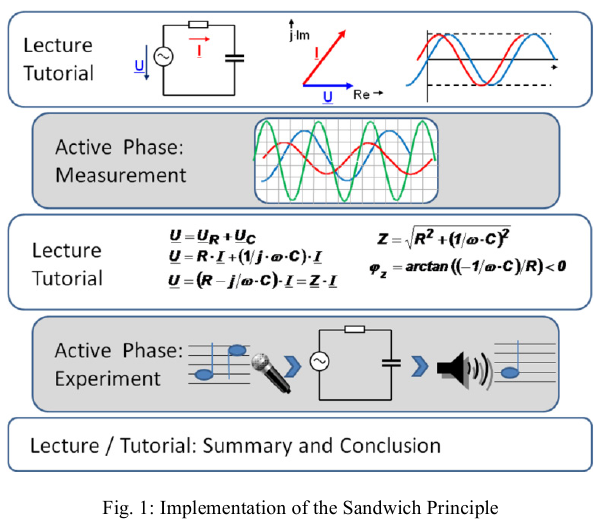
Fig. 1: Implementation of the Sandwich